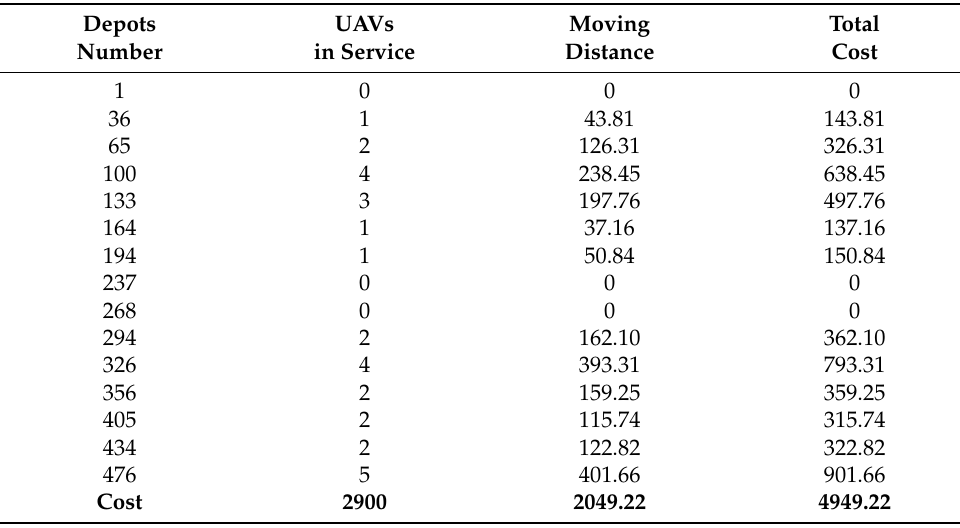
Table 5. Total cost for delivery represented in Figure